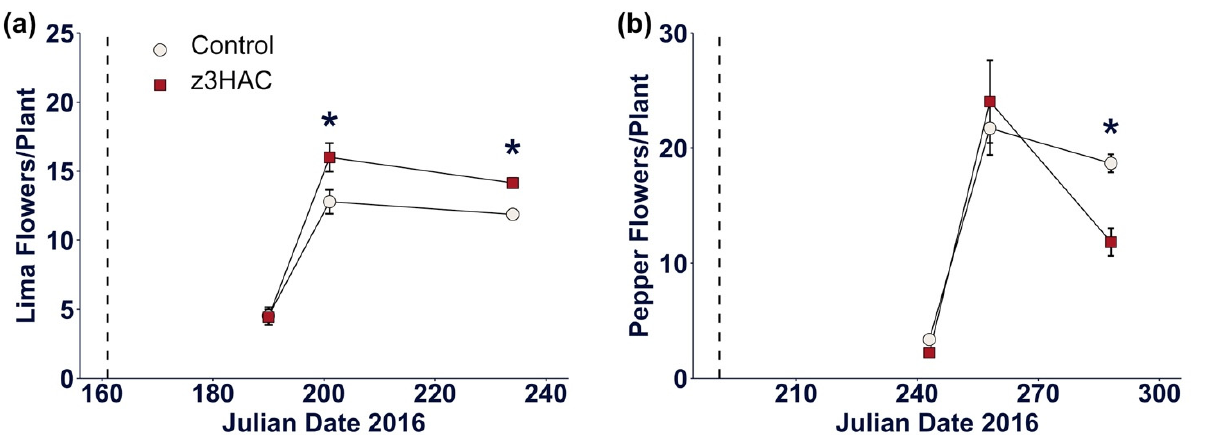
Figure 4. Total flower production in ( a ) Phaseolus lunatus (lima bean) and ( b ) Capsicum annuum (pepper). Open circles represent control plants (receiving lanolin-only vials); filled squares represent plants receiving a persistent application of vials containing 10 ng/h cis -3-hexenyl acetate ( z 3HAC) dissolved in lanolin. Dropdown lines indicate the initial application of z 3HAC treatment: lima bean and pepper plants were first exposed on 10 June 2016 (Julian date 161) and 11 July 2016 (Julian date 192), respectively. Points represent the averages +/ − SE. Asterisks (*) represent p < 0.05 between treatment and control at each time point. See Supplemental Table S3 for statistics.